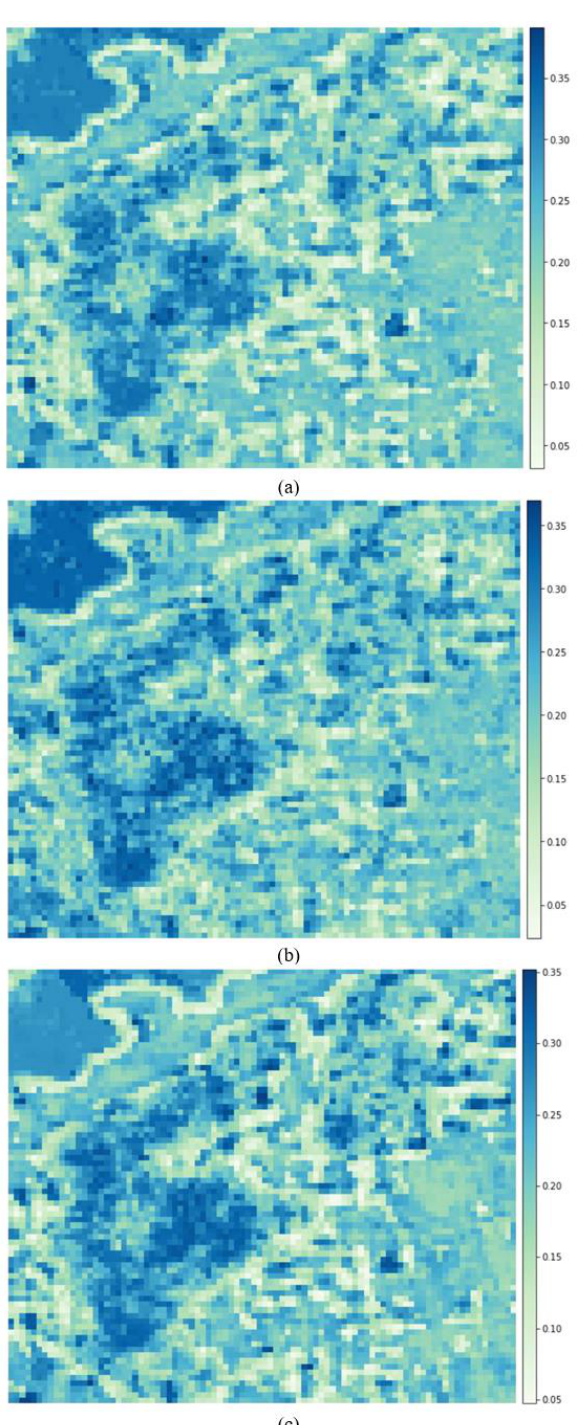
Figure 7. Predicted soil moisture maps using tree-based (a) GBRT, (b) XGB, and (c) RF